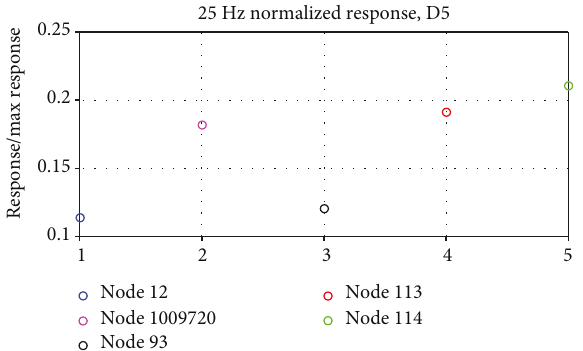
Figure 24: D5, 25Hz normalized responses, double excitation tests.